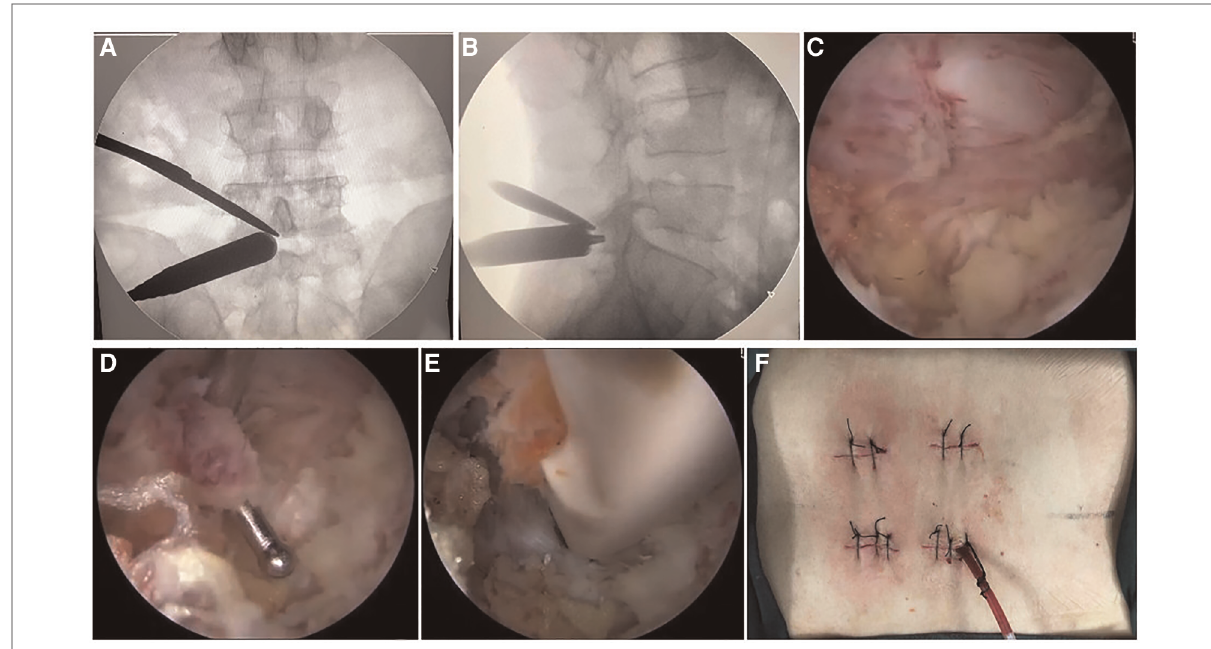
FIGURE 2 Intraoperative photographs during biportal endoscopic decompression, debridement, and interbody fusion, combined with percutaneous screw fi xation. ( A,B ) The position of the two portals under the guidance of C-arm fl uoroscopy. ( C ) The endoscopic image of light red in fl ammatory granulation tissue. ( D ) Endoscopic image of separated and exposed granulation tissue. ( E ) Endoscopic showed implantation of a cage fi lled with rifampin mixed with autologous bone. ( F ) Photograph of the incision after completion of